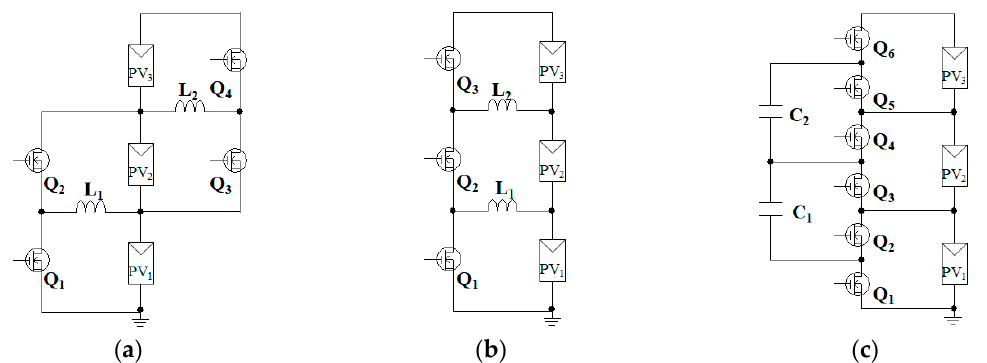
Figure 4. DPP converters for adjacent PV modules: ( a ) Bidirectional pulse width modulation (PWM) converter [3–8], ( b ) multistage chopper [9,10], ( c ) switched capacitor converter [11–14].